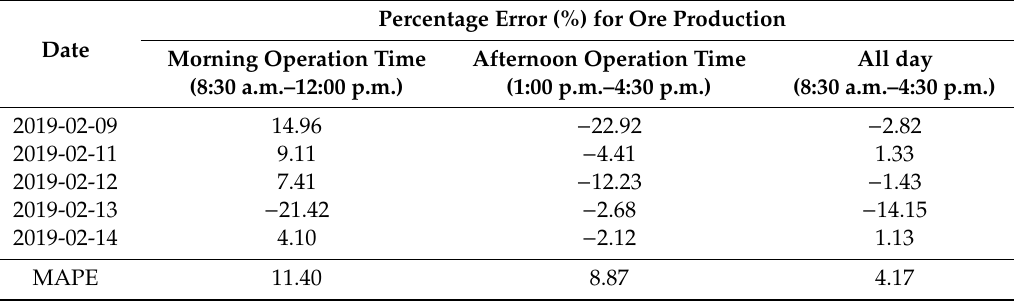
Table 10. Prediction error between predicted and actual ore productions during five working days. Percentage Error (%) for Ore